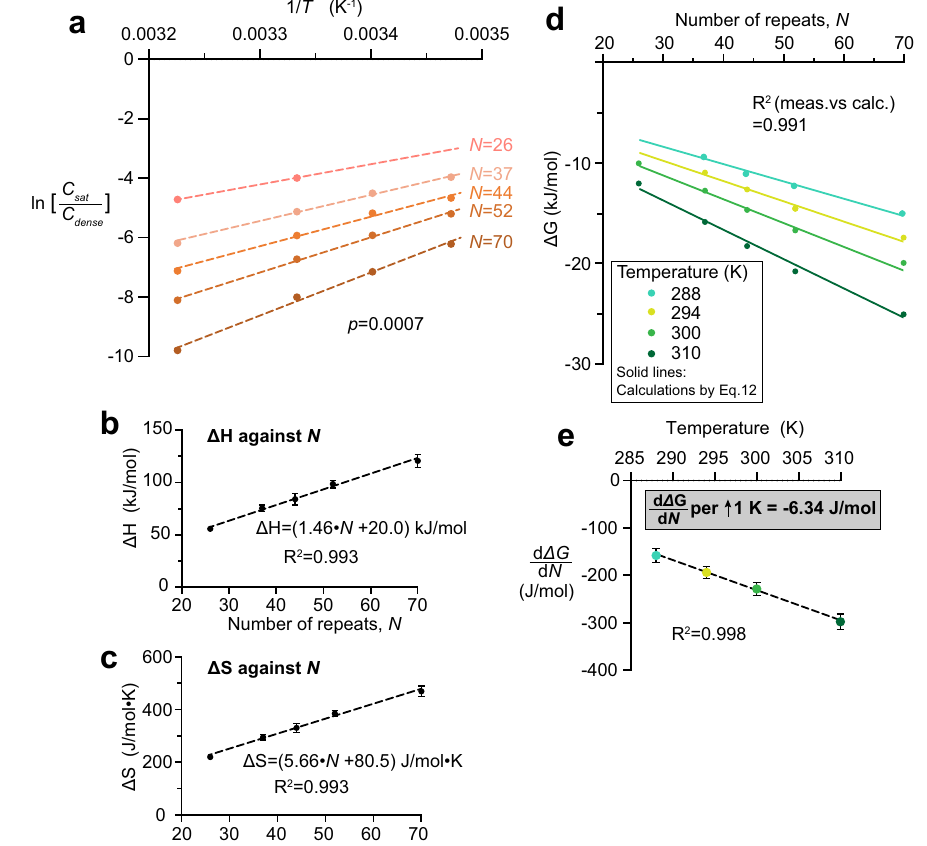
Fig.6|Enthalpy,entropyandGibbsfreeenergychangeinphaseseparationper FG repeat unit. a ln ( C sat / C dense ) is plotted against 1/ T for different numbers ( N ) of